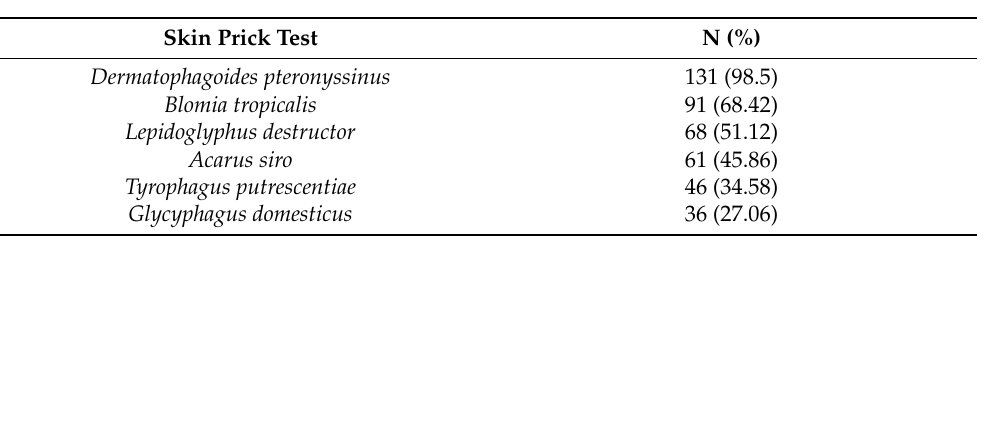
Table 2. Prevalence of sensitization to mites by Skin Prick